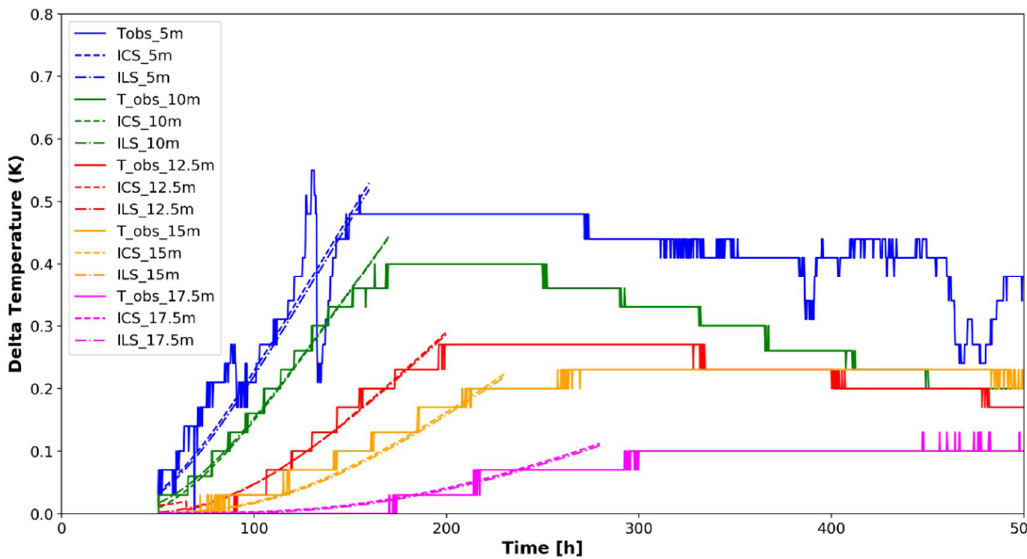
Figure 7. Thermal response monitored in the observation well (T_obs) at 5 different depths, compared to temperature calculated with ICS and ILS response functions.